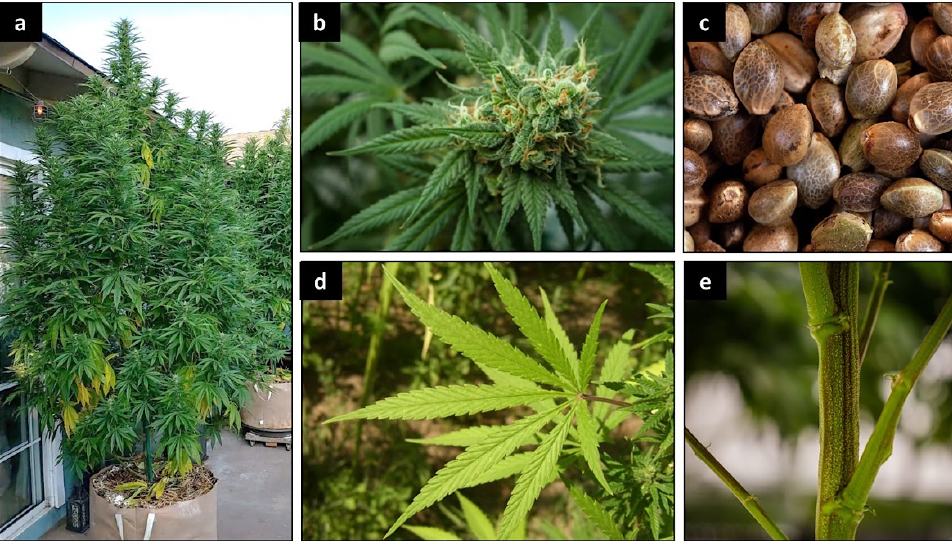
Figure 1. Cannabis sativa L. General aspect ( a ); inflorescence ( b ); seed ( c ); leaf ( d ); stem ( e ). This plant is also characterized by long, fine flowers (Figure 1b). It has glandular hairs that make it fragrant and sticky [34,35]. At post-germination, young male and female plants cannot be distinguished. It is only during the last phase of growth, when flowers start appearing, that sex determination becomes possible [24,36]. The female flowers have no petals and consist of two long white, yellow or pink stigmas. Their calyx (less than 3–6 mm) envelops the ovary containing a single ovule. The female flowers appear in pairs in the axils of small leaves named bracts, these bracts contain numerous glandular trichomes where cannabinoids, mainly THC, accumulate [34,37,38]. On the other hand, the male flowers have five sepals of approximately 5 mm length, with yellow, white or green color [33,39]. The male plants develop small pollen sacs that serve to fertilize the female plants with hairy, resinous stigmas [34,36,40]. The Cannabis leaves are stipulate and opposite, with palmate (five to seven unequal), elongated and spiny segments with toothed margins (Figure 1d). Towards the top of the axis, the leaves become alternate and are inserted on the stem in an opposite arrangement every 10–30 cm [39]. These plants have cystolithic, tectorial and resin-secreting hairs; the latter have a voluminous base ending in a cluster of several cells, with each one secreting resin [39]. The root is taproot with a length of up to 30 cm, but the lateral roots reach 20 to 100 cm. In addition, in peaty soils, the lateral roots are more strongly developed, and the main root grows to a depth of 10–20 cm [41]. The growth rate of the root system is quite slow in the initial stages of vegetation, in contrast to the aerial part of the Cannabis plant, which grows intensively and rapidly